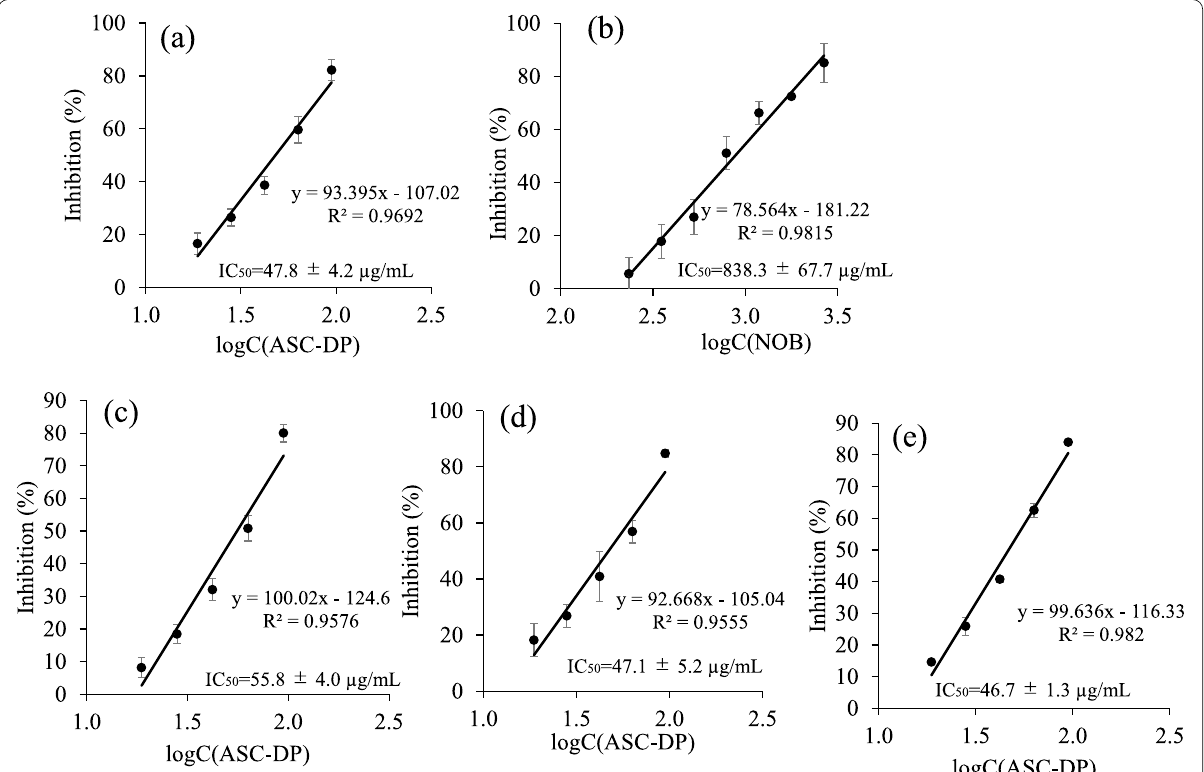
Fig. 9 DPPH radical scavenging test of Sol/ASC-DP/NOB ASC-DP/NOB 8/1/1. The results are expressed as the mean =